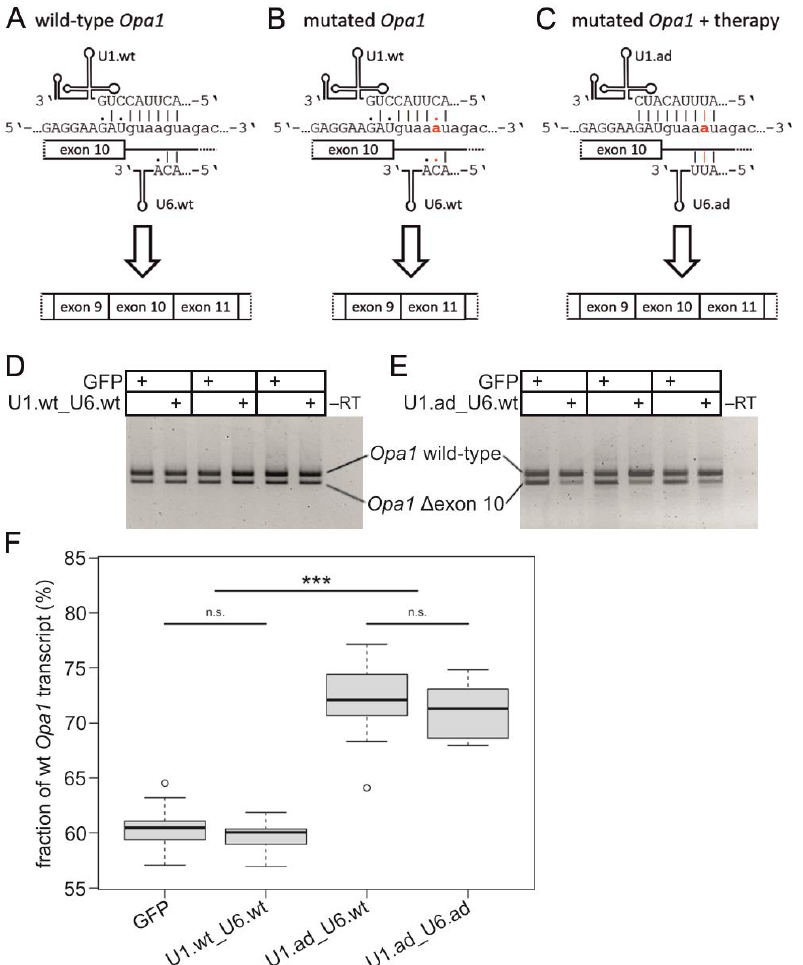
Figure 1. Correcting Opa1 splice defects with engineered U1 splice factors. ( A ) Wild-type U1 (U1.wt) binds with seven Watson-Crick base-pairings to the Opa1 wild-type splice donor site of exon 10. Wild-type U6 (U6.wt) binds with only two base-pairings to the Opa1 pre-mRNA. ( B ) The mutation c.1065+5G>A abolishes Watson-Crick base-pairing at the highly-conserved +5 position in the intron (highlighted in red), leading to skipping of exon 10 during splicing. ( C ) Our treatment strategy uses engineered U1 (U1.ad) to overcome the effect of the mutation c.1065+5G>A and to bind to all nine base pairings of the mutated splice donor site of exon 10 in Opa1 . Engineered U6 (U6.ad) can bind with all three possible base-pairings. ( D , E ) RT-PCR analyses of Opa1 splicing after treatment with engineered U1 in three Opa1 enu/+ mice each. The larger RT-PCR fragment corresponds to the correctly spliced wild-type Opa1 , the shorter corresponds to Opa1 skipping exon 10. ( D ) The U1.wt_U6.wt treatment did not change Opa1 splicing in Opa1 enu/+ eyes compared to the contralateral mock (GFP) controls. ( E ) The fraction of correctly spliced wild-type Opa1 transcripts was increased upon treatment with U1.ad_U6.wt compared to the contralateral mock control. ( F ) Quantification of Opa1 wild-type and exon10 skipping fragments revealed a significant increase in relative wild-type band intensity (with respect to total Opa1 transcripts) upon treatment with U1.ad. Statistical significances were calculated by Mann-Whitney U test. ***: p < 0.001; n.s.: not significant, p > 0.05. –RT: cDNA reaction without reverse